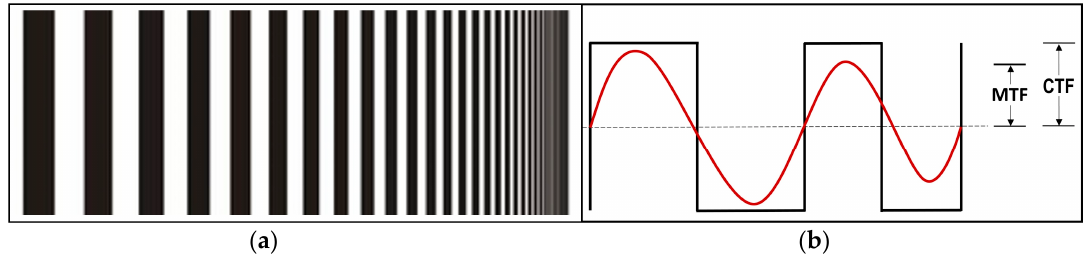
Figure 6. ( a ) Template with striped black and white bars of decreasing width. ( b ) Components of CTF and MTF. CTF is usually equal to or greater than